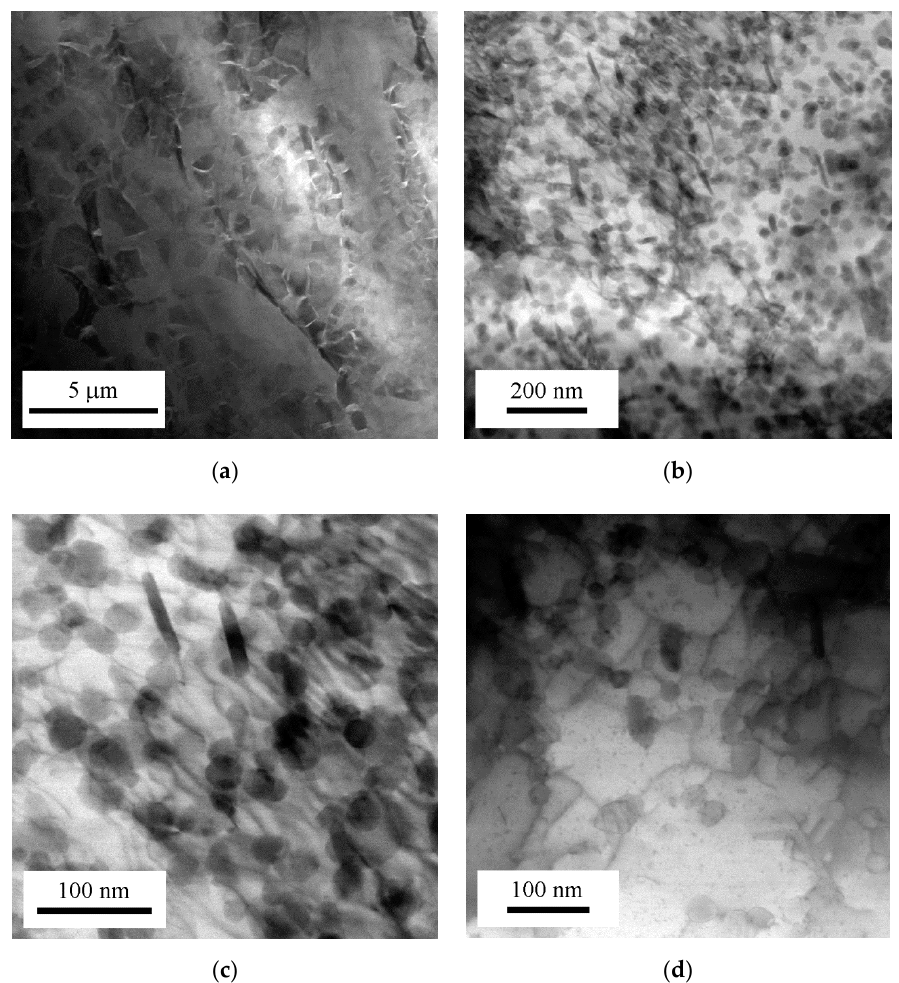
Figure 11. Bright field TEM micrographs of the alloy Al 95.4 Mn 1.8 Cu 1.6 Be 1.2 aged at 400 ◦ C for 1 h and compressed with 0.4 true strain. ( a ) Broken phases at a cell boundary, ( b ) an area inside a cell, ( c ) an area, with a higher precipitate density, ( d ) an area, with a lower precipitate